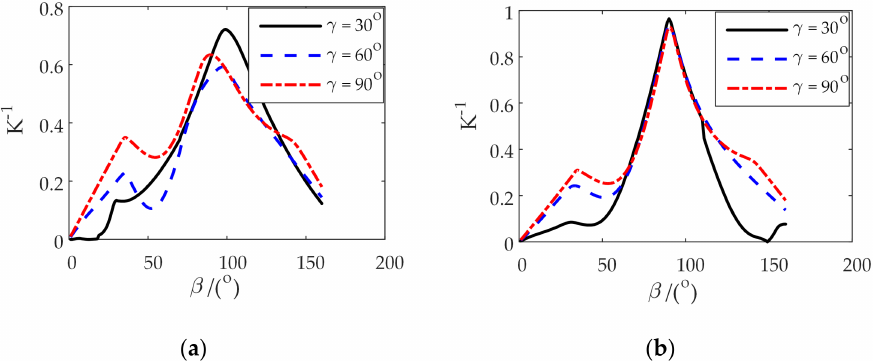
Figure 13. Curve of the reciprocal of the condition number and uplift angle. ( a ) α = 60 ◦ ; ( b ) α = 90 ◦ .